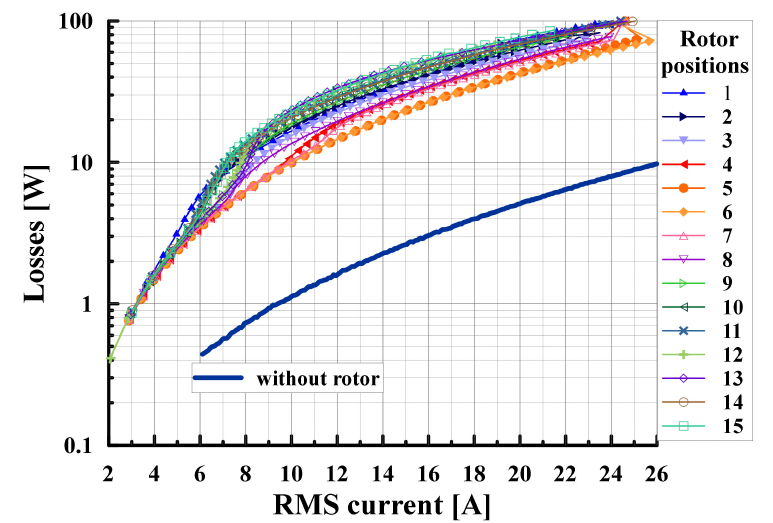
Figure 12. Stator losses as a function of current at different rotor positions at a frequency of 50 Hz. Same frequency without rotor is depicted for reference.